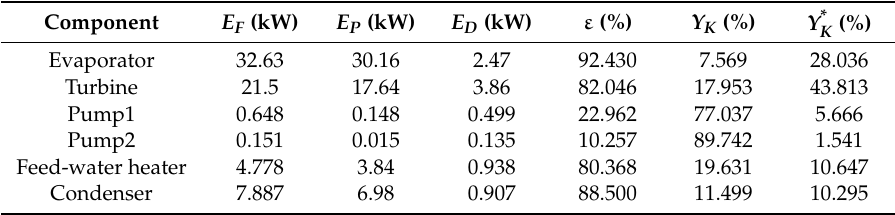
Table 6. Results from exergy calculations for SRORC.